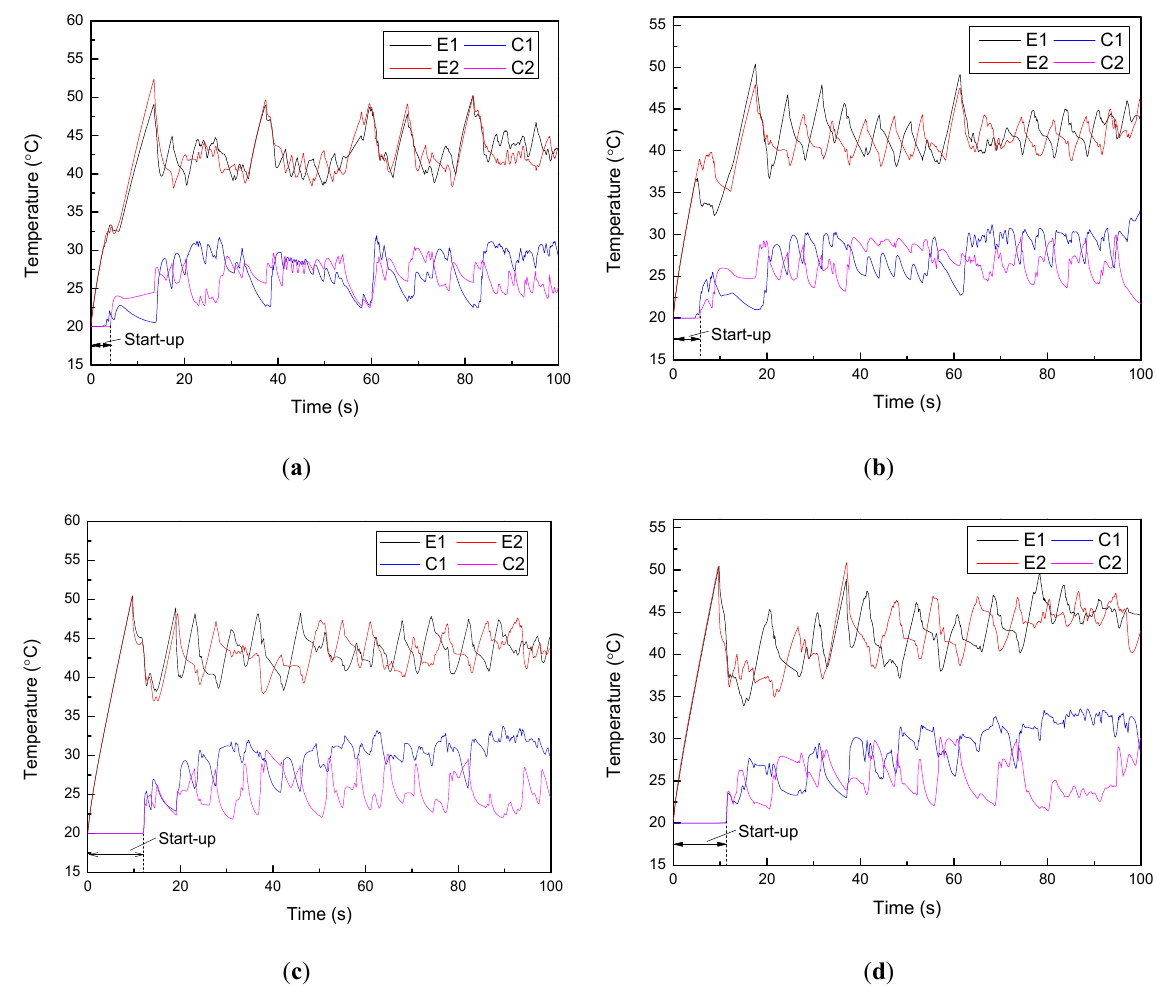
Figure 11. The temperature fluctuation of the PHP at 20 W with different lengths of the adiabatic section: ( a ) 60 mm, ( b ) 120 mm, ( c ) 180 mm, and ( d ) 240 mm.